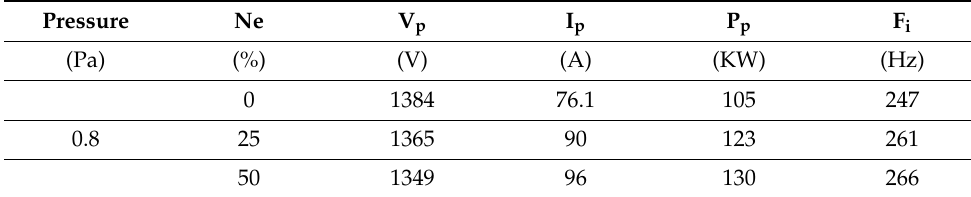
Table 1. Deposition conditions for the DLC